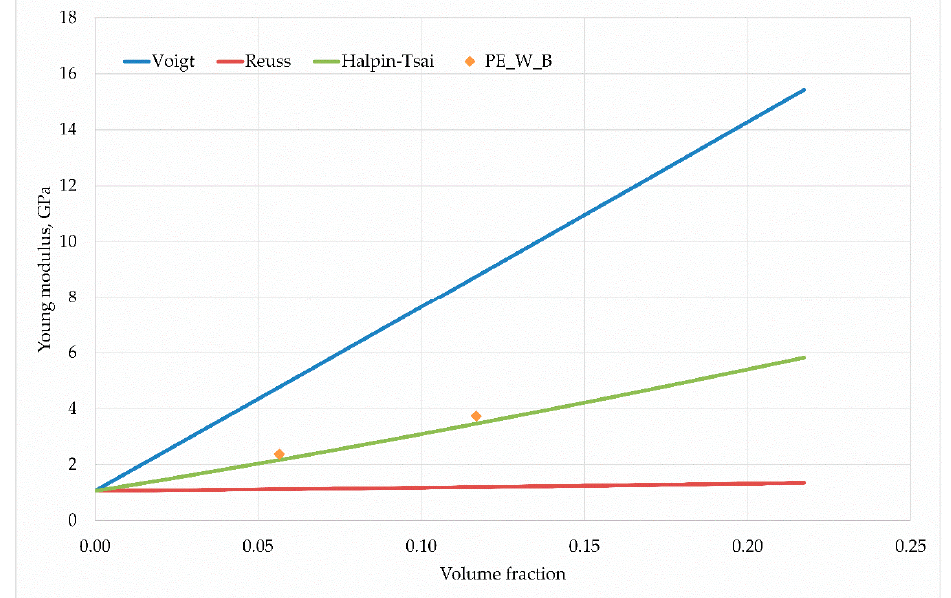
Figure 11. Young’s modulus dependence on the wood flour and basalt fiber content in the PE matrix.